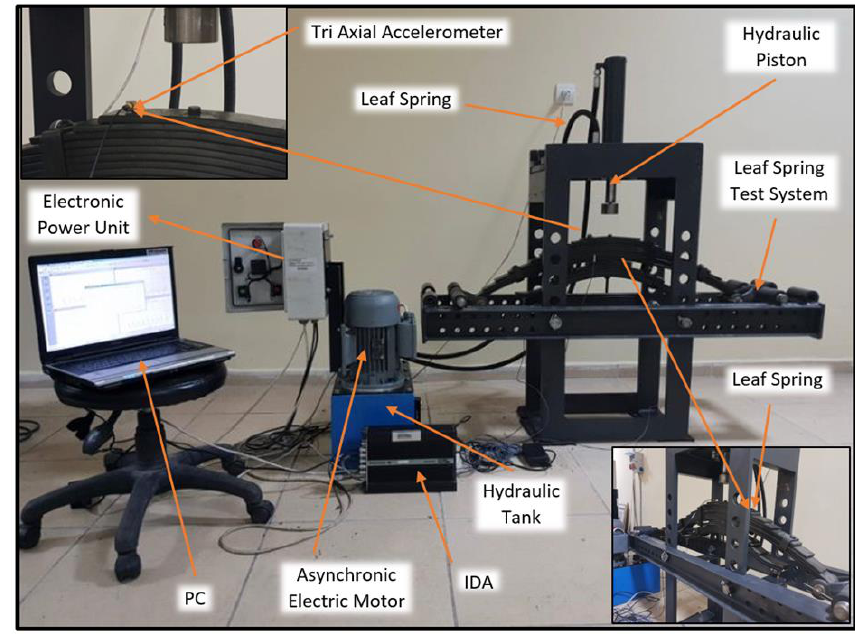
Figure 3. The leaf spring test stand designed for the vibration analysis.